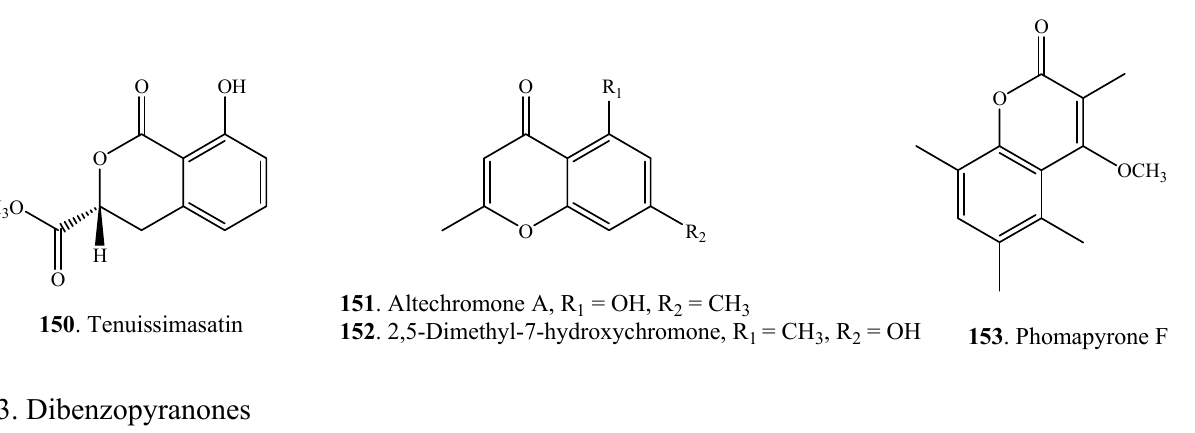
Figure 7. Monobenzopyranones isolated from Alternaria fungi.